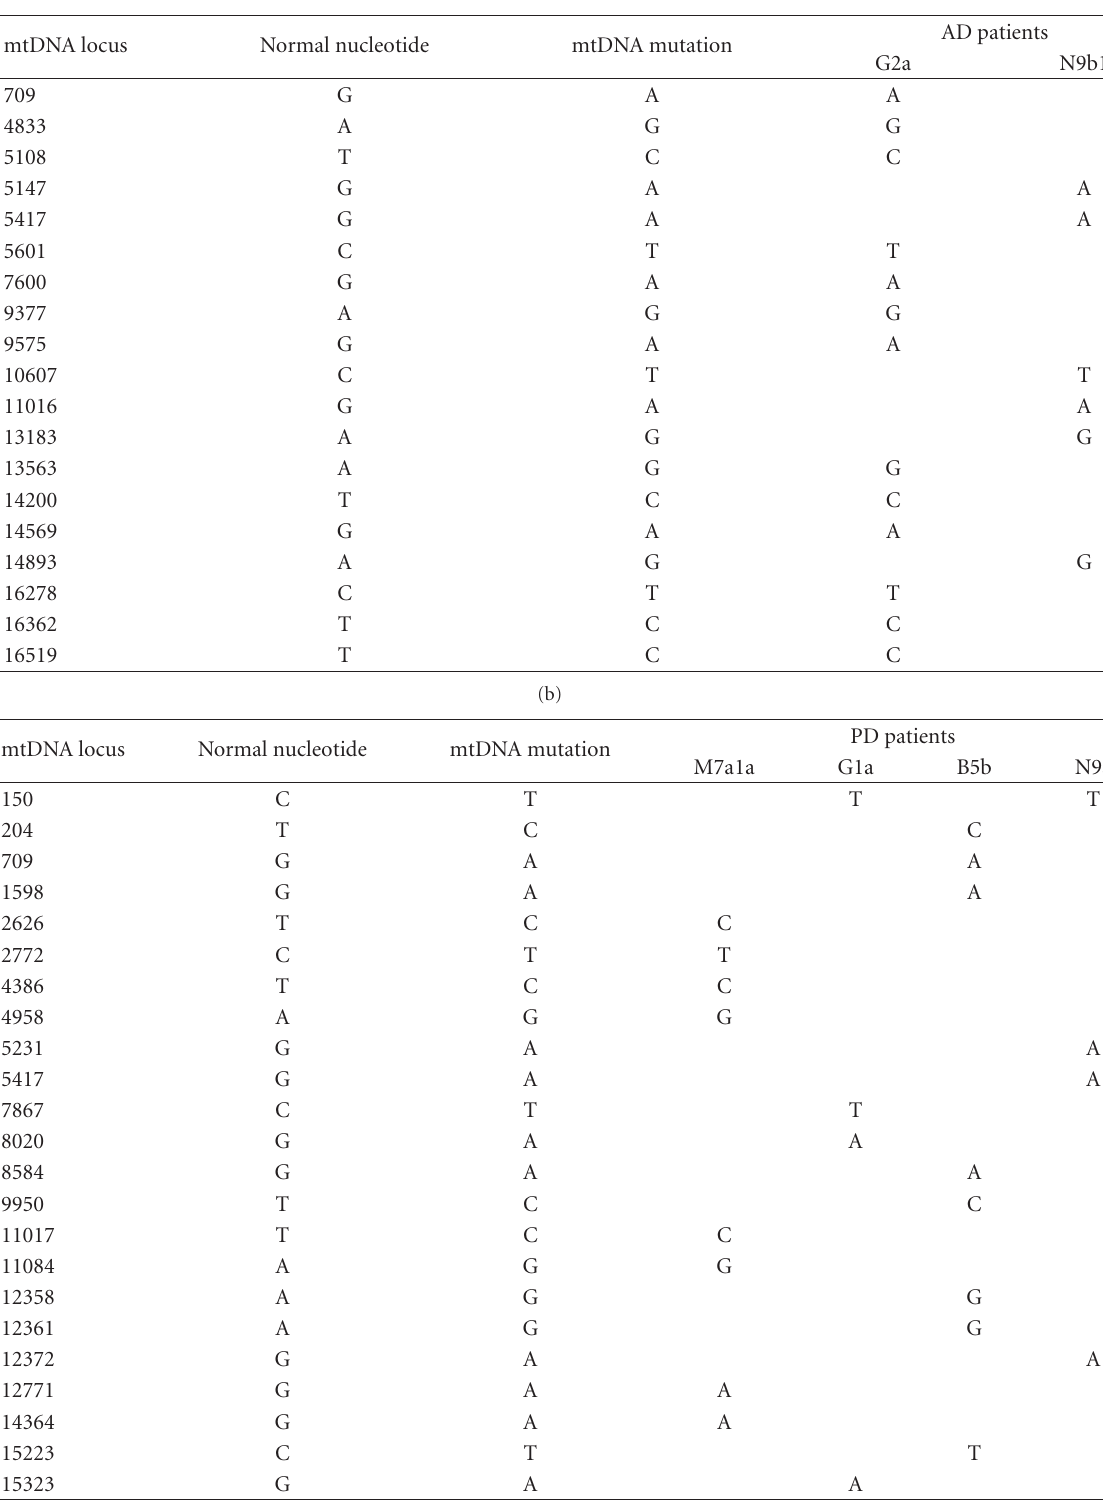
Table 3: (a) mtDNA mutations for the haplogroups of the AD patients, (b) mtDNA mutations for the haplogroups of the PD patients, (c) mtDNA mutations for the haplogroups of the T2D patients, (d) mtDNA mutations for the haplogroups of the T2D patients with angiopathy, (e) mtDNA mutations for the haplogroups of the centenarians, (f) mtDNA mutations for the haplogroups of the semi-supercentenarians, (g) mtDNA mutations for the haplogroups of the non-obese young males, (h) mtDNA mutations for the haplogroups of the obese young